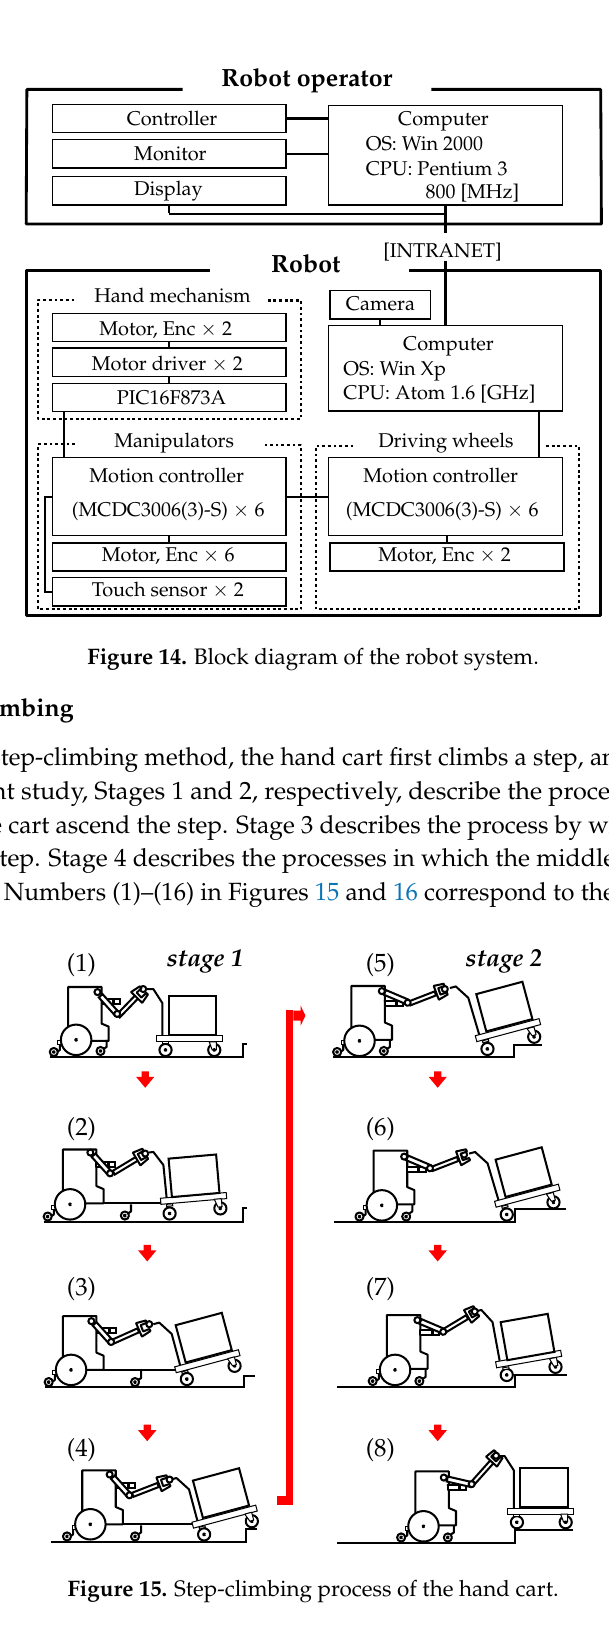
Figure 13. Robot lifting its front wheels